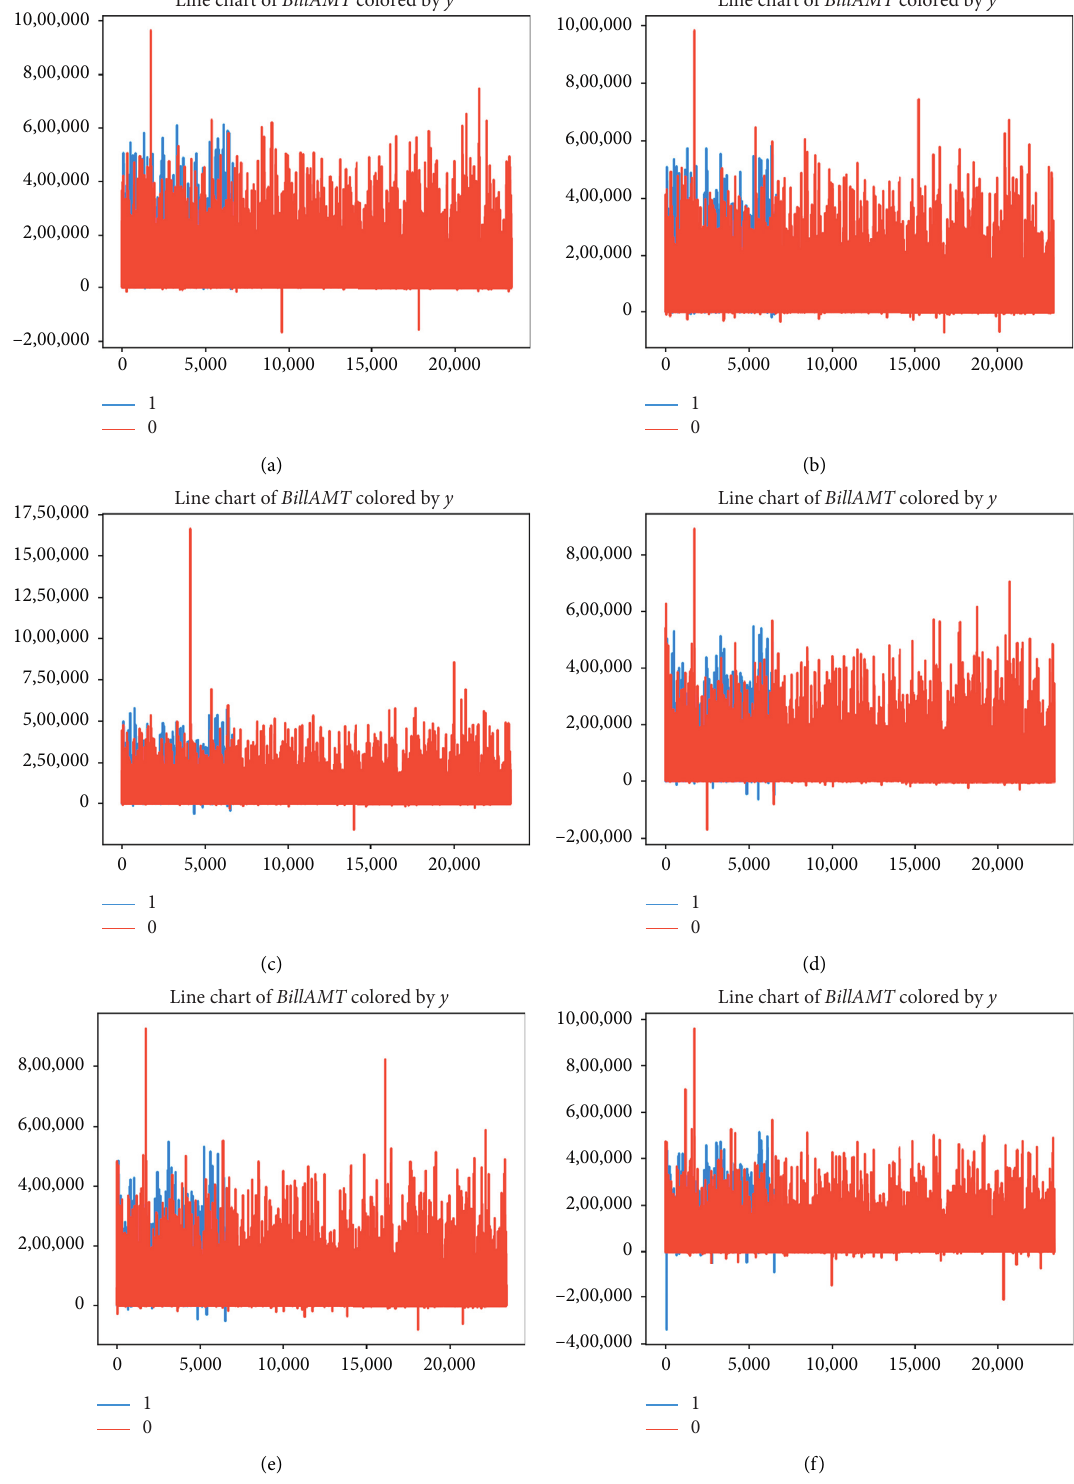
Figure 8: Line chart of billamt. (a) Amount of bill statement in September. (b) Amount of bill statement in August. (c) Amount of bill statement in July. (d) Amountof bill statement in June. (e) Amount of bill statement in May. (f) Amount of bill statement in